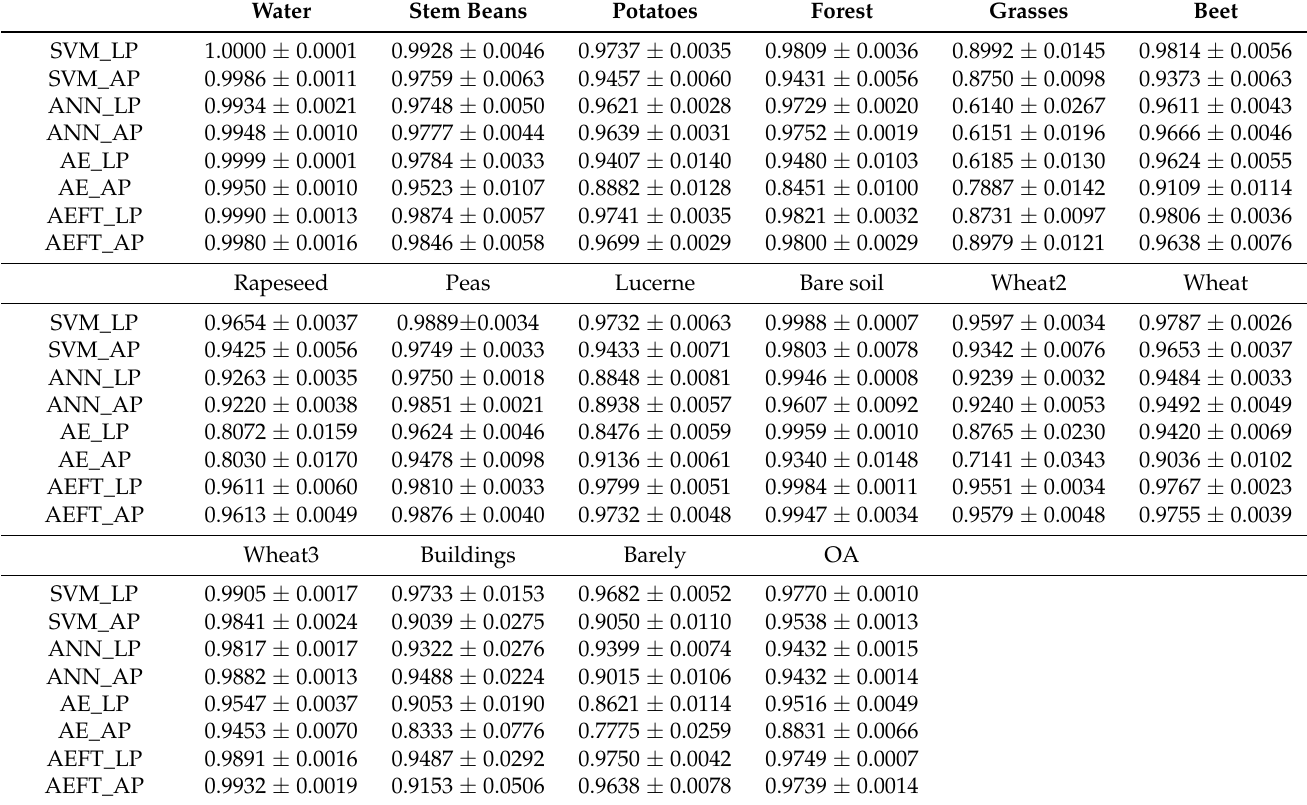
Table 11. Objective evaluation indicators of four classifiers on the learned parameters and all parameters of Touzi decompo- sition for the Flevoland